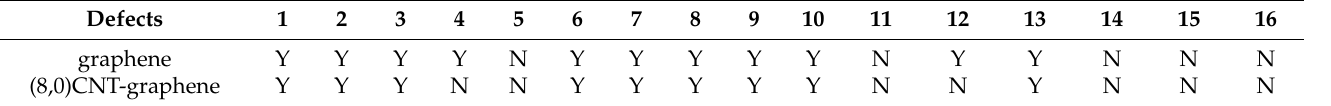
Table 1. Statistical results for 16 kinds of defects for independent graphene and (8,0)CNT-graphene.